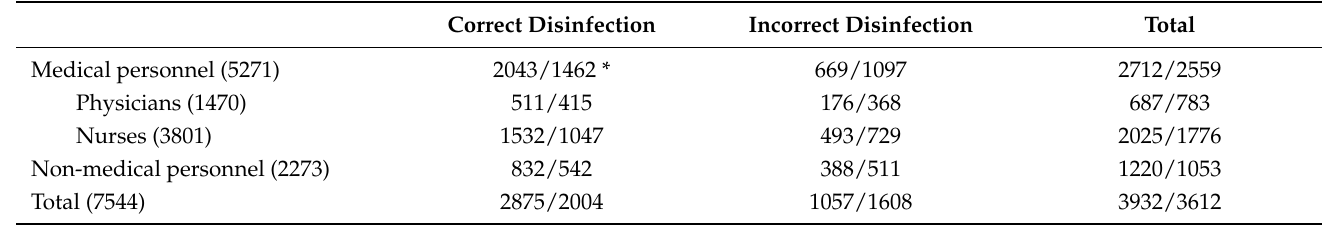
Table 5. Assessment of the correctness of hand disinfection behavior and compliance with the BBE concept in various professional